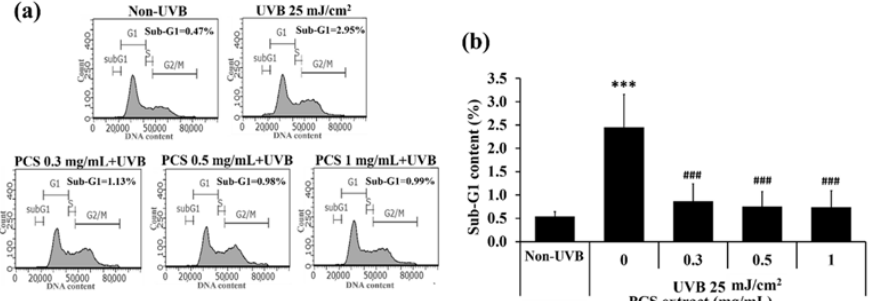
Figure 2. Effect of PCS extract on UVB-induced cell death in HaCaT cells. Cells were pre-treated with PCS extract for 1 h and exposed to 25 mJ/cm 2 UVB followed by incubation in fresh medium for 24 h. Then, DNA contents of the cells were determined using flow cytometry analysis. Cellular DNA was fixed and stained with Guava cell cycle ® reagent. ( a ) Histogram of cell cycle distribution. ( b ) Sub-G1 content. Results are the average values ± SD ( n = 3). *** p < 0.001; vs. the non-UVB group and ### p < 0.001 vs. the UVB control group.